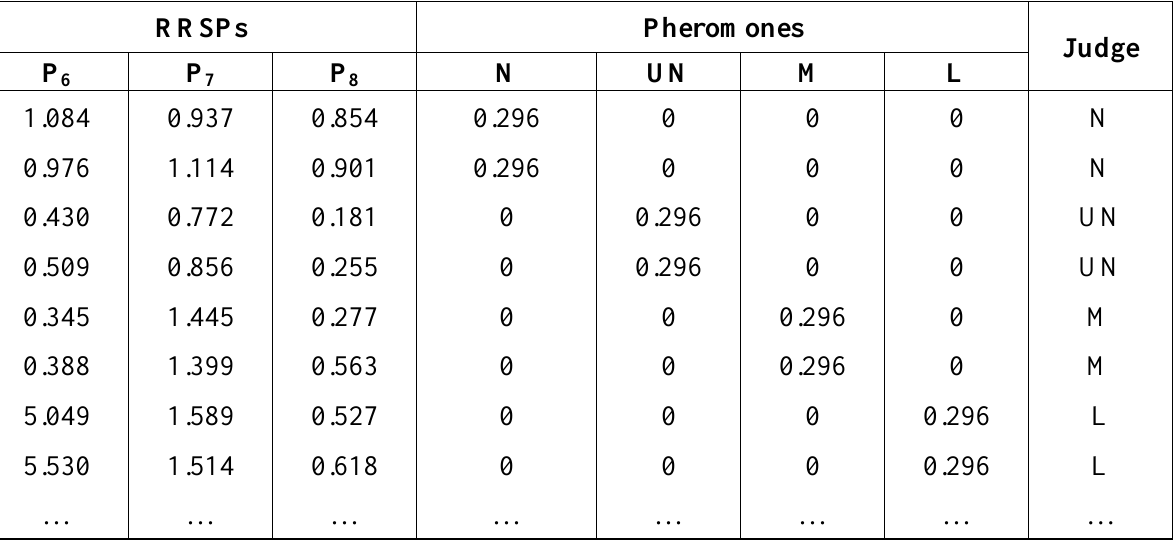
Table 5. Diagnosis result using proposed